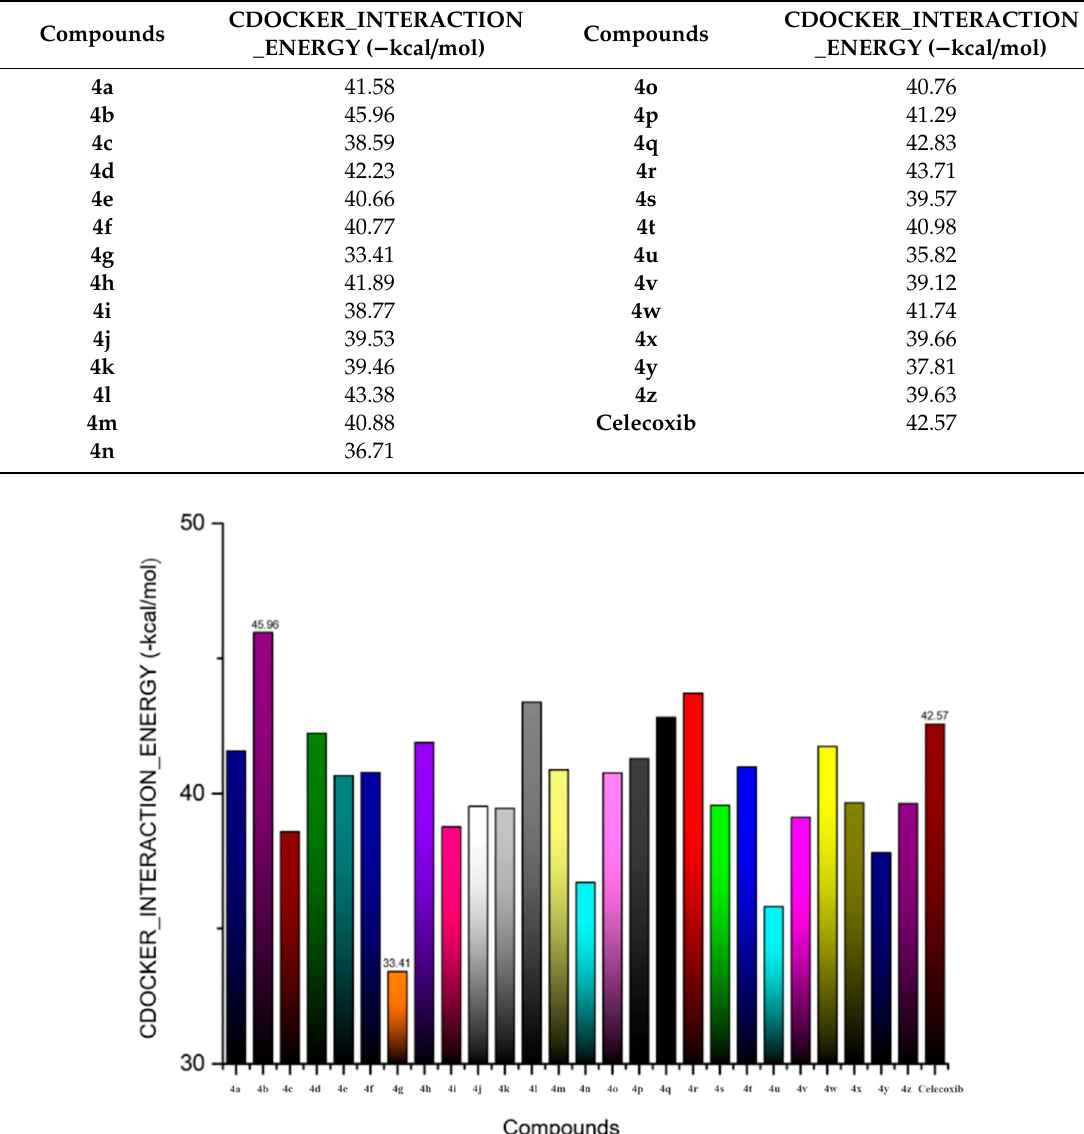
Figure Figure 6. The histogram about CDOCKER_INTERACTION_ENERGY of compounds 4a – 4z and Celecoxib.